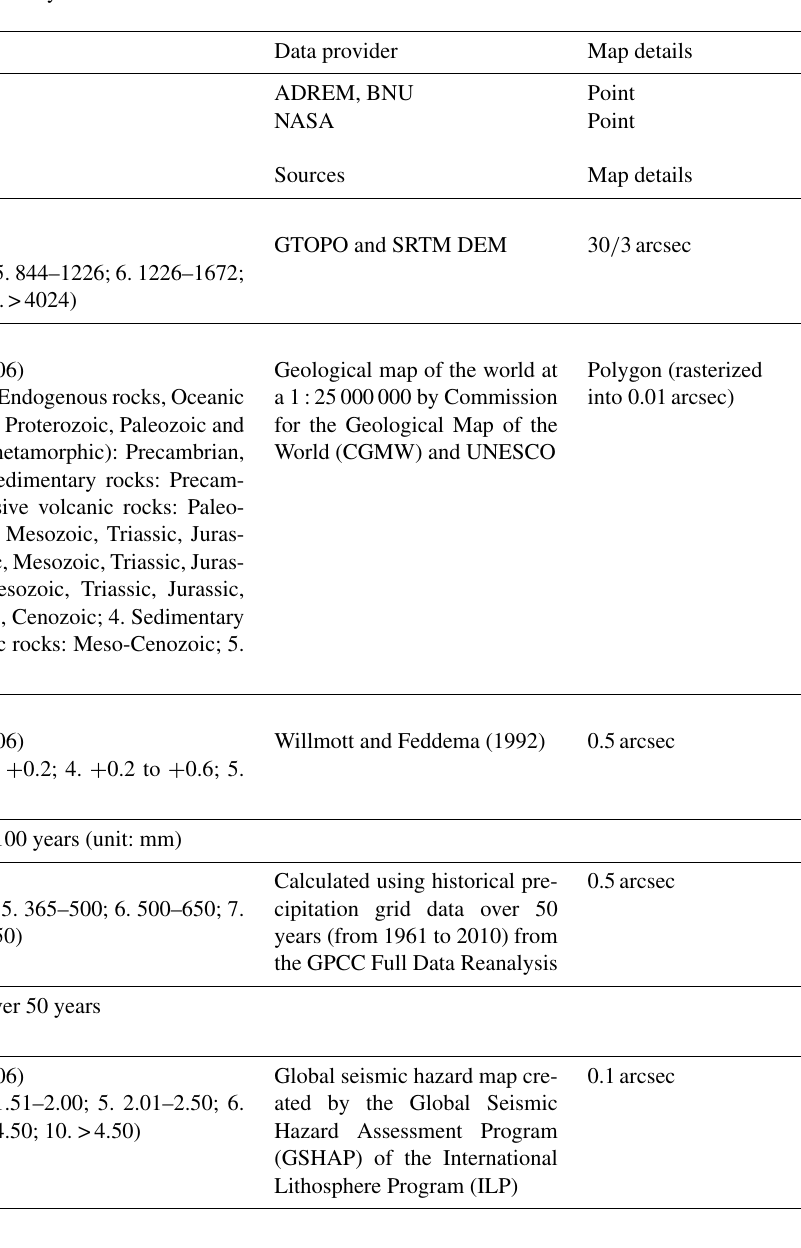
Table 2. Input variables used in logistic regression